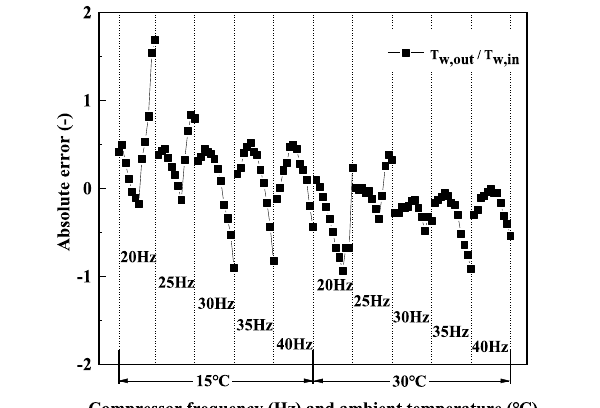
FIGURE 12 | Comparison of the experimental GCW s with those predicted.